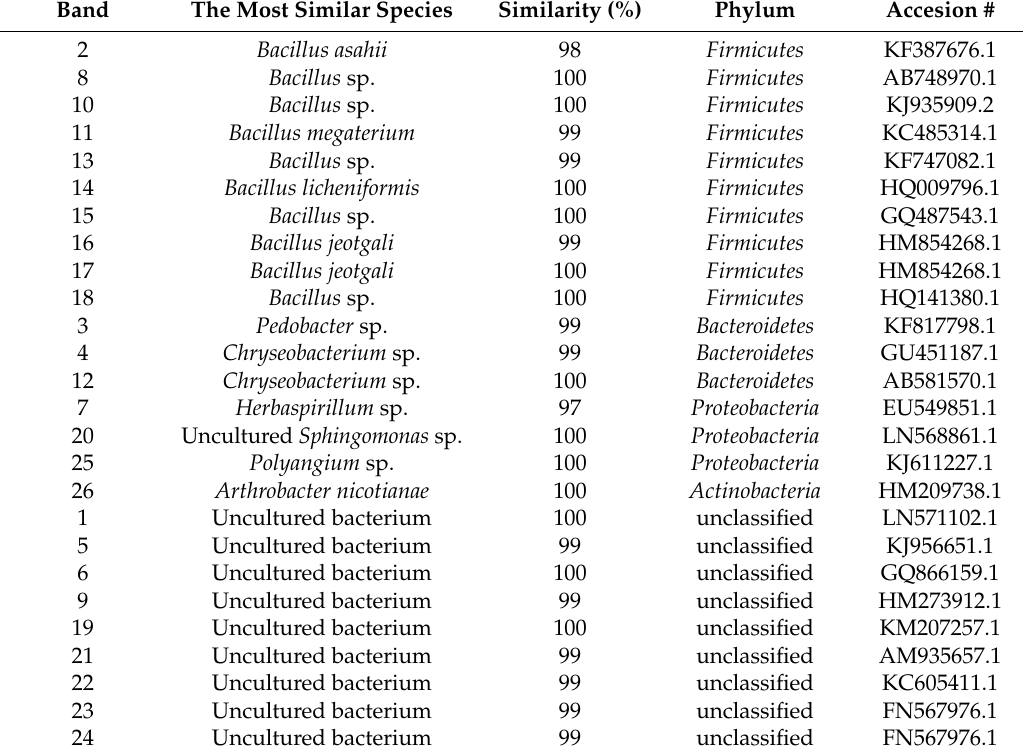
Table 3. Sequence similarity of the main bacterial in different cucumber rhizosphere soil samples in